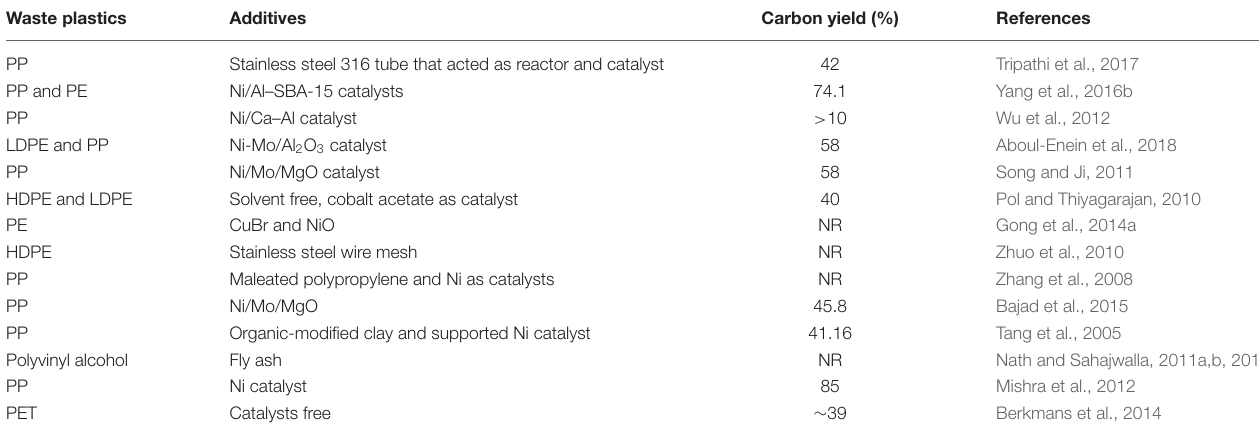
TABLE 4 | Synthesis methods of CNTs from waste plastics.